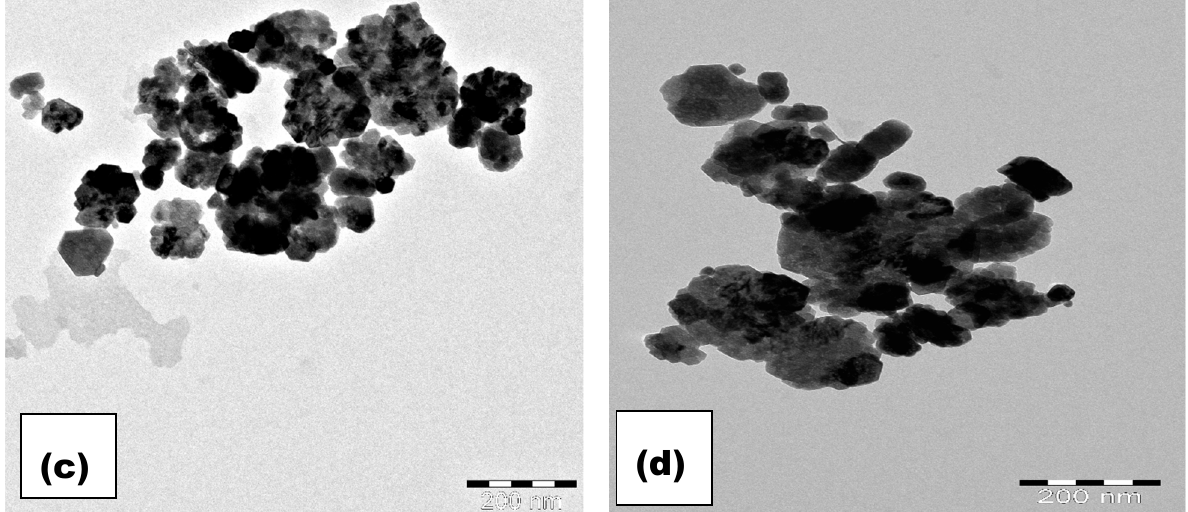
Figure 7. TEM analysis of ( a ) CoFe 2 O 4 , ( b ) 0.5% W-CoFe 2 O 4 , ( c ) 0.1% W-CoFe 2 O 4 , and ( d ) 0.15% W-CoFe 2 O 4 nanoparticles.